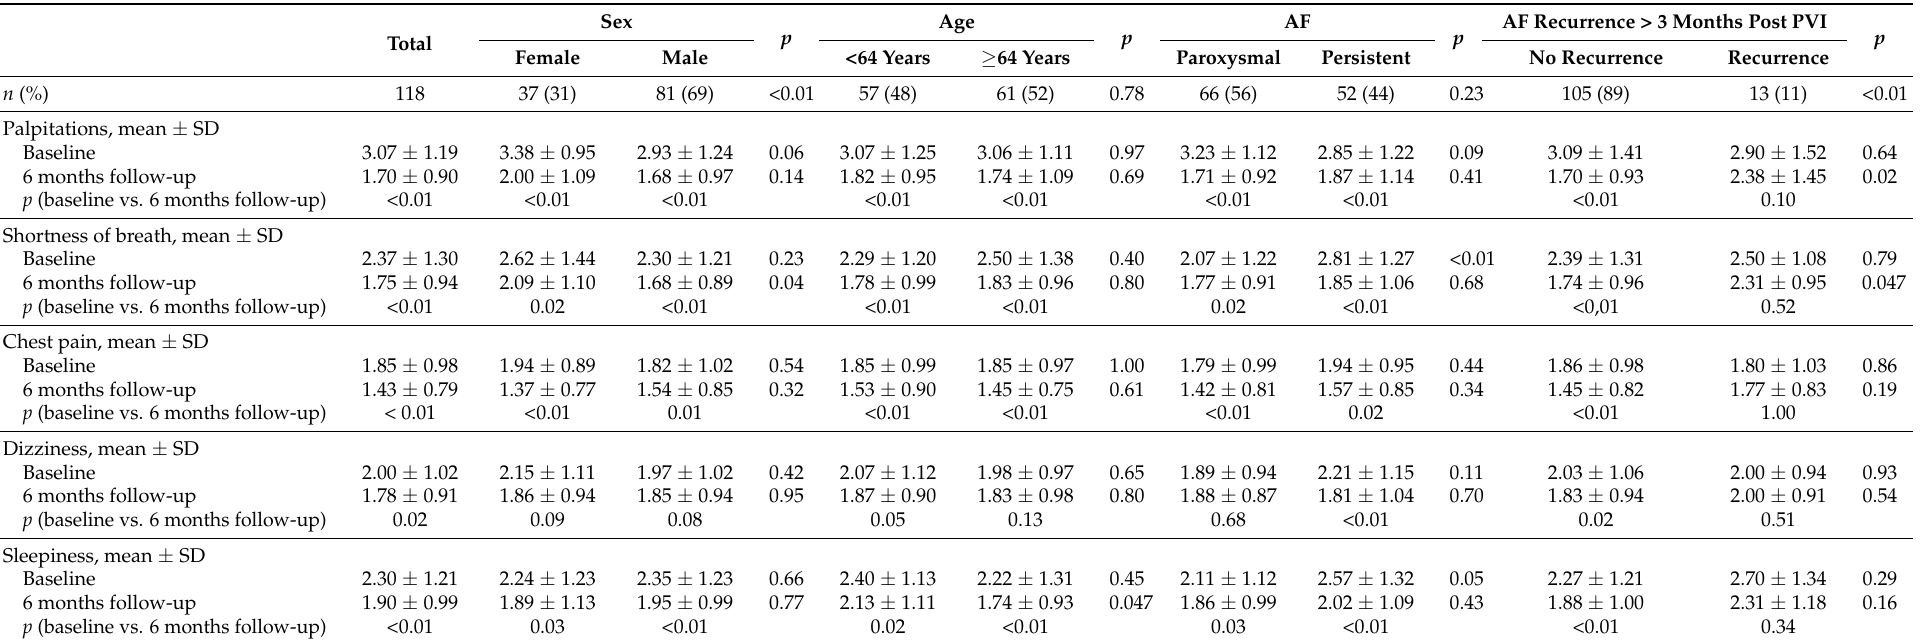
Table 3. Type and intensity of symptoms at baseline and 6 months